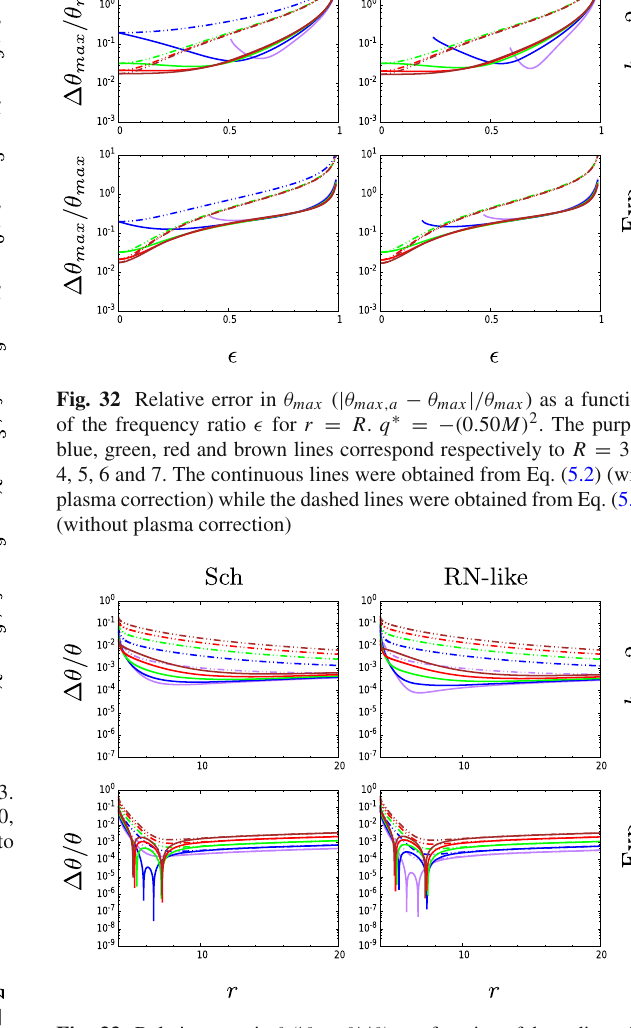
Fig. 33 Relative error in θ ( | θ a − θ | /θ ) as a function of the radius r for δ( R ) = π/ 2. q ∗ = − ( 0 . 50 M ) 2 , R = 4 M . The purple, blue, green, red and brown lines correspond respectively to (cid:11) = 0 . 1, 0 . 2, 0 . 3, 0 . 4 and 0 . 5. The continuous lines were obtained from Eq. (5.2) (with plasma correction)whilethedashedlineswereobtainedfromEq.(5.1)(without plasma